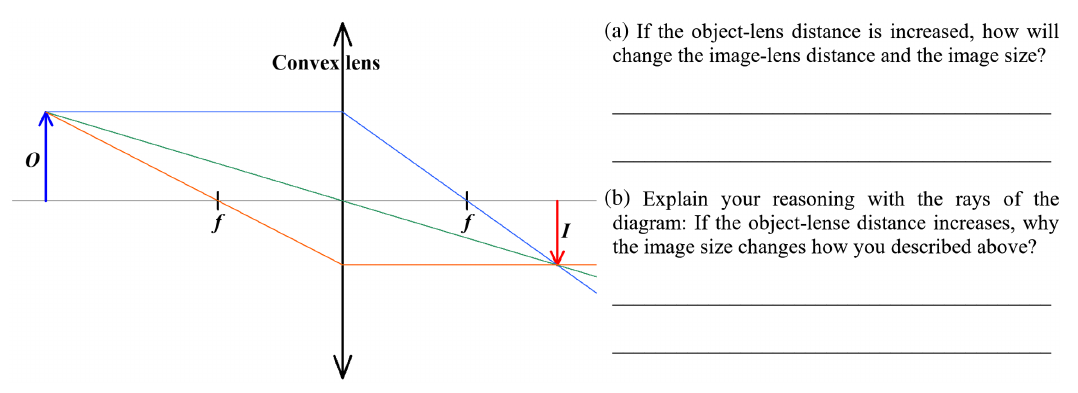
FIG. 7. Examples of deeper understanding items for assessment of RCA [items 1(b) and 1(c)